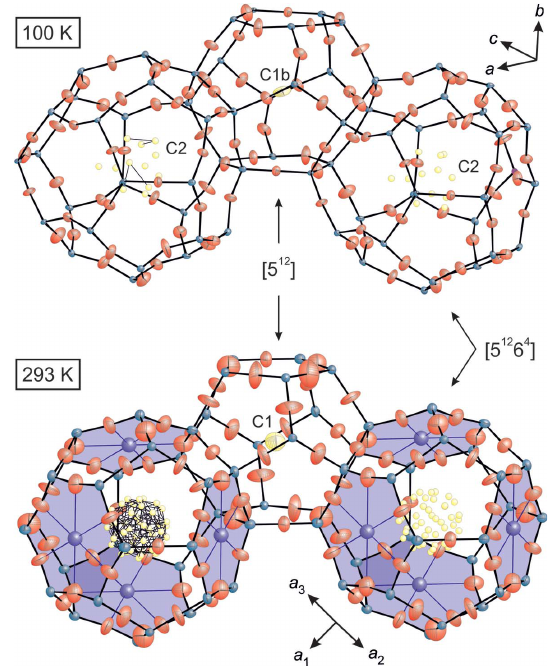
Figure 8 Detail of the chibaite framework at T = 100 K (above) and 293 K (below): the [5 12 ]- and [5 12 6 4 ]-type cages are linked via five-membered rings. All framework atoms (Si: blue, O: red) and the fully occupied C1 position (yellow) are shown as 50% probability ellipsoids determined from the corresponding U ij values. All partially occupied C2 positions (small yellow spheres) are located in the central region of the [5 12 6 4 ] cage. The purple areas mark the six-membered ring units with the Na atoms and Na—O bonds (in